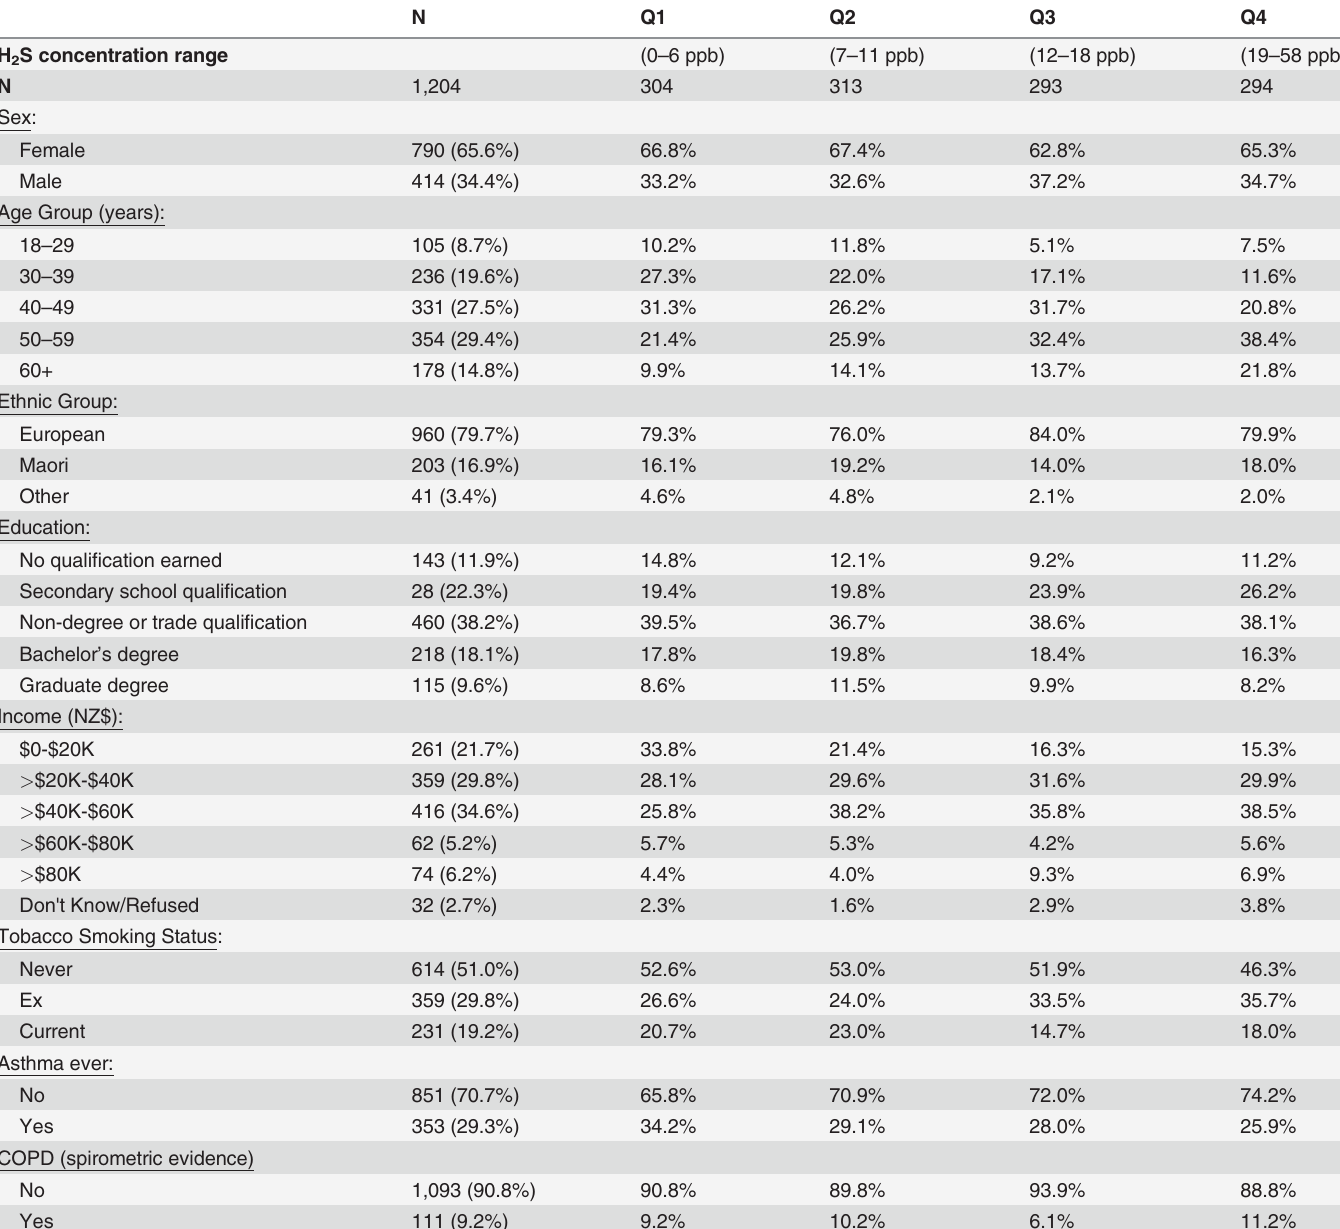
Table 1. Description of the study population, by quartiles (Q1 to Q4) of estimated average time-weighted H 2 S exposure concentration over the last 30 years for study participants who performed pre-bronchodilator spirometry to a satisfactory standard, Rotorua, New Zealand, 2008 – 2010. N